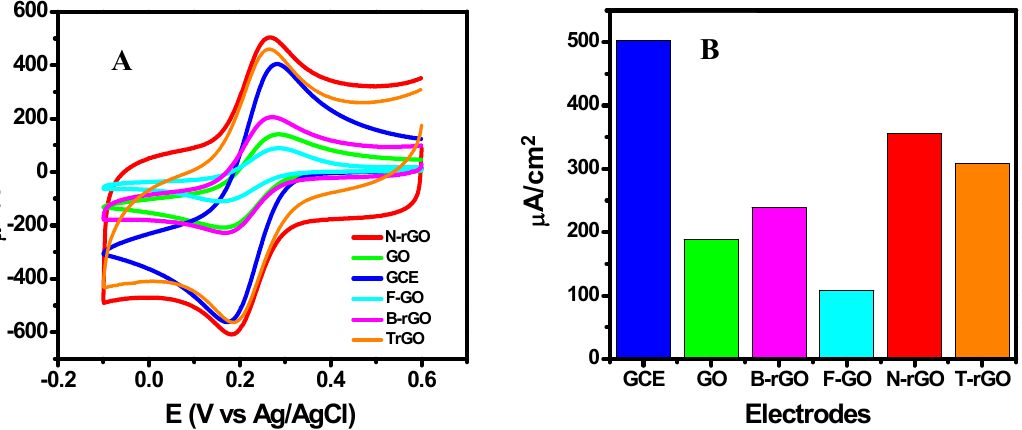
Figure 3. ( A ) Cyclic voltammograms for di ff erent electrodes recorded in a KNO 3 -ferricyanide media (5 mM K 3 [Fe(CN) 6 ] in 0.2 M KNO 3 at a scan rate of 50 mV / s; ( B ) Bar graph of the peak current densities of the di ff erent Figure 3. (A) Cyclic voltammograms for different electrodes recorded in a KNO 3 ‐ ferricyanide media (5 mM K 3 [Fe(CN) 6 ] in 0.2 M KNO 3 at a scan rate of 50 mV/s; (B) Bar graph of the peak current densities of the different electrodes.